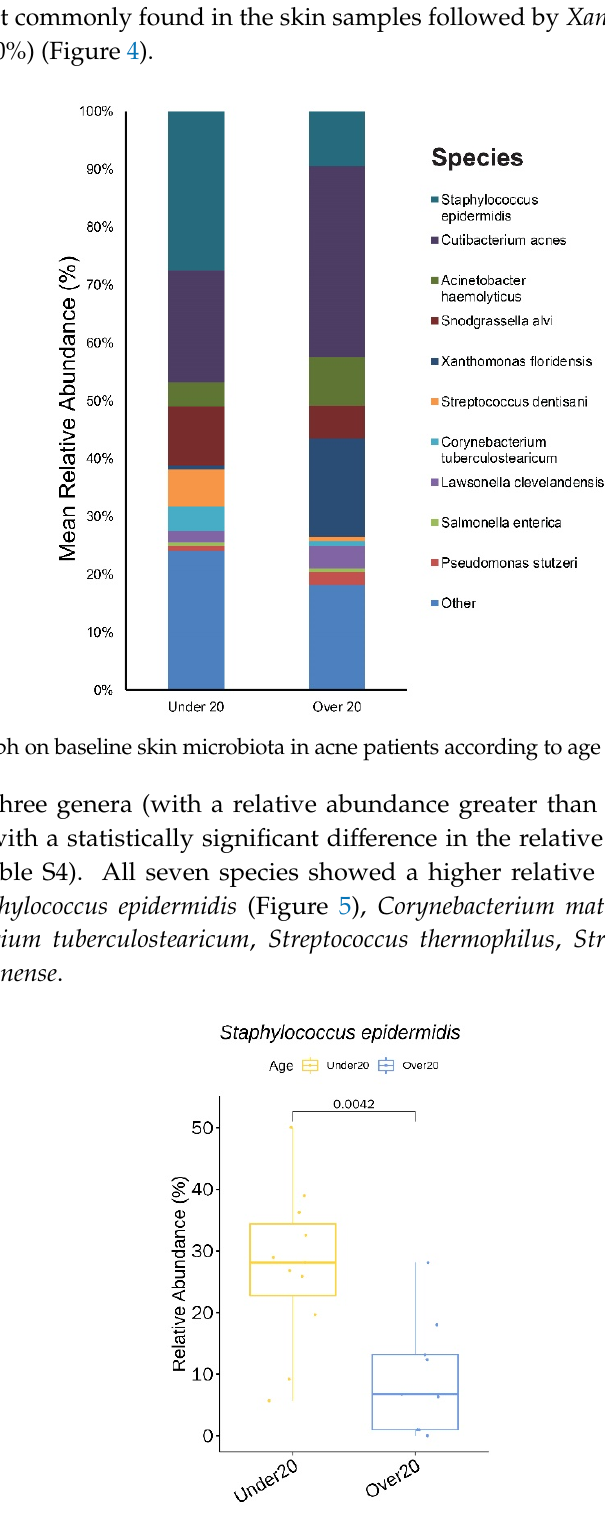
Figure 5. Staphylococcus epidermidis showing a significantly higher relative abundance in the under 20 age group at baseline.